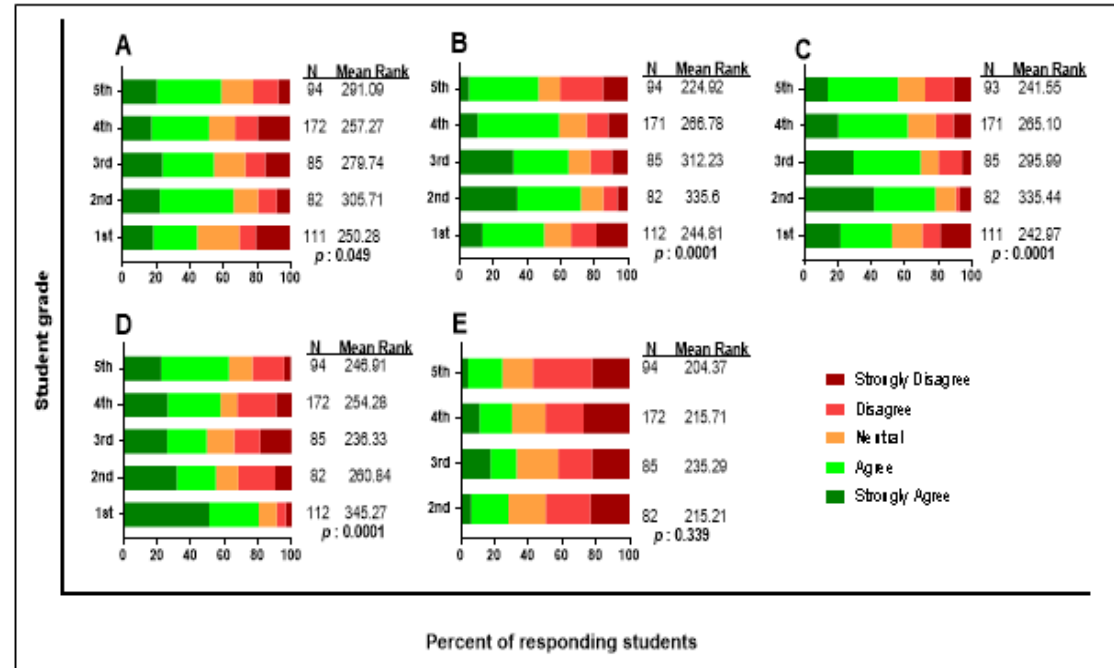
Figure 2. Student perception of hybrid education model implemented during the academic year of 2020- 2021. A: Although all the lectures were virtual, in-class final exam improved my scientific gain compared to online exams. B: Having the practical part of the lab on campus improved my understanding even though the lecture part of the lab was virtual, C: hybrid education model is better than distance education, D: It would have been better to have the whole lab session on campus. E: My scientific gain in distance education component is similar to in-class education. Kruskal Wallis test was used to compare means of student responses to different questions according to their year of the study. N: number of students responding to the